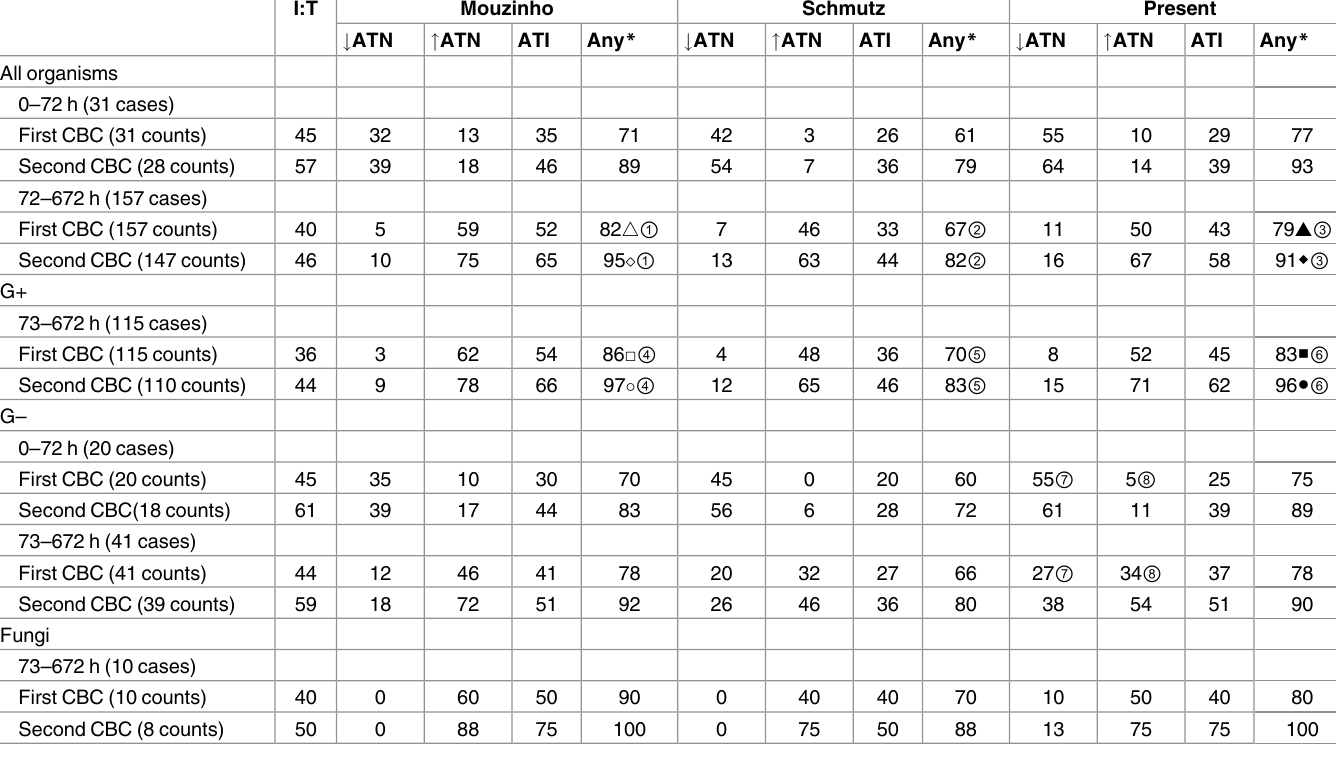
Table 2. Comparison of the sensitivity of the revised RRs and those of Mouzinho’s RRs and Schmutz’s RRs for neutrophils in VLBW neonates with proven